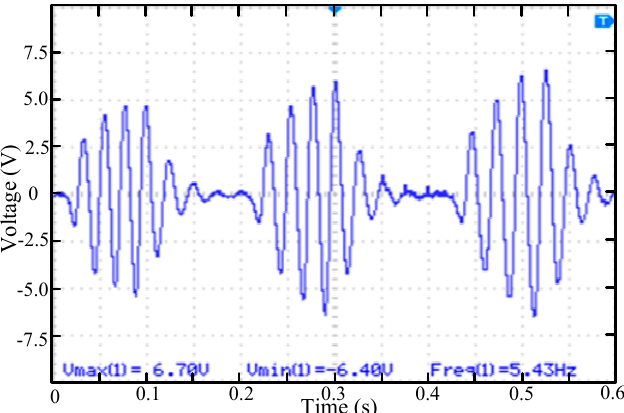
Figure 9. The voltage waveform of the piezoelectric beam while rotating mass block rotates with four permanent magnets (positions 1, 2, 3, 4).